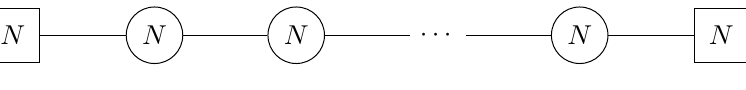
Figure 17 . Homogeneous linear